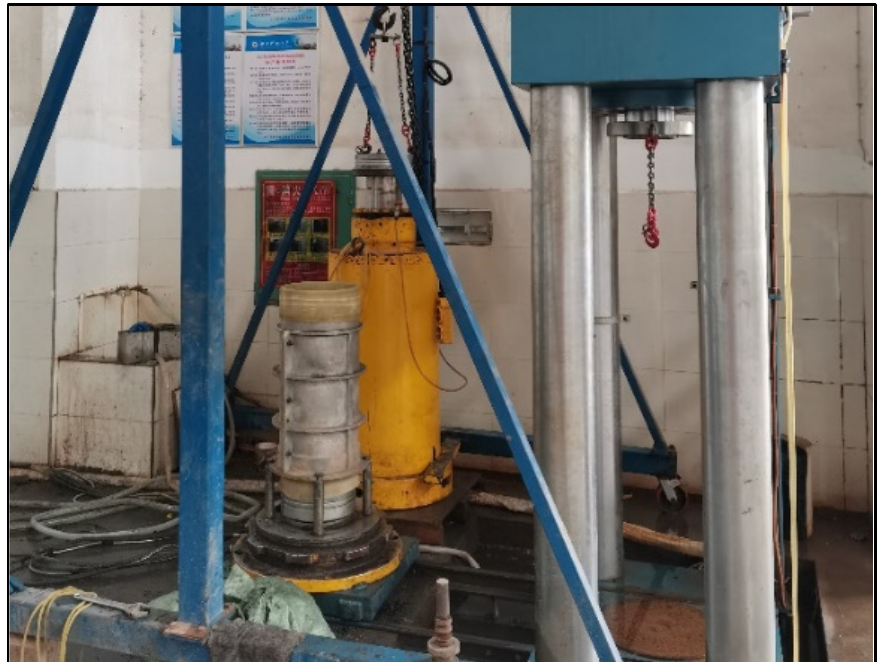
Figure 3. The large-scale dynamic and static triaxial instrument.